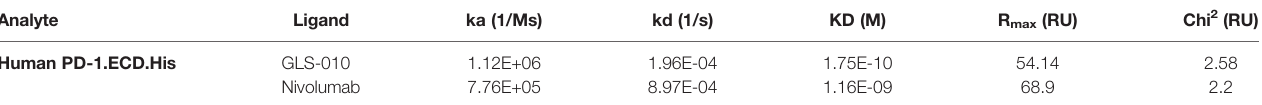
SPR, surface plasmon resonance; k a , association rate constant; k d , dissociation rate constant; KD, af fi nity constant; R max , maximum observed response; Chi 2 , goodness of fi t